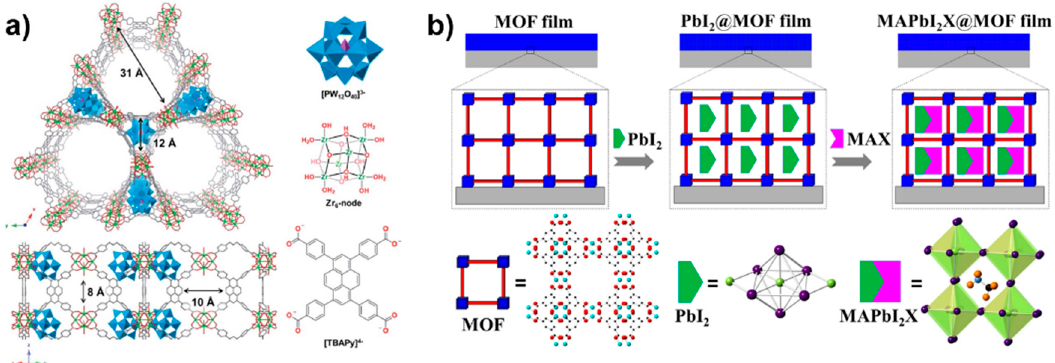
Figure 4. ( a ) The structure of PW 12 @NU-1000. ( b ) The preparation of MAPbI 2 X@HKUST-1. Reproduced with permission from Buru et al. [58] (Copyright 2018 Royal Society of Chemistry) and Chen et al. [16] (Copyright 2016 American Chemical Society), respectively.